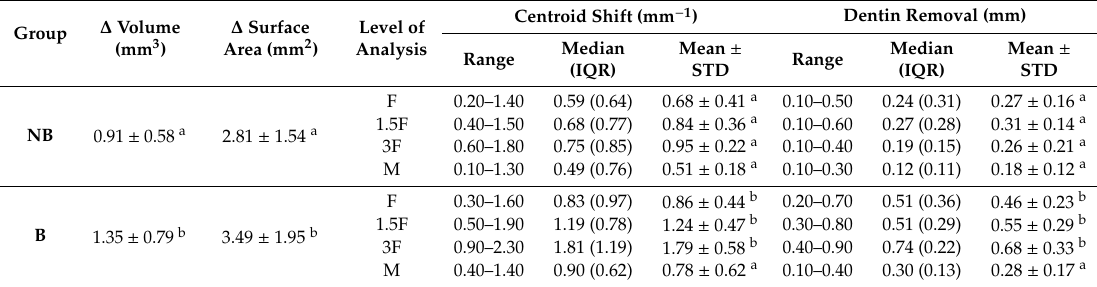
Table 2. Variations in 3D and 2D parameters in both groups after shaping (mean ± STD). Statistical significance indicated by p < 0.05. Superscript letters in the same column indicate significant di ff erences between groups ( p < 0.05). For 2D parameters, significance was compared for the same level of analysis. (1.5F = 1.5 mm from the furcation; 2D = two-dimensional; 3D = three-dimensional; 3F = 3 mm from the furcation; B = brushing group; F = furcation; M = point of maximum curvature; NB = no-brushing group; STD = standard deviation; IQR = interquartile range). Di ff erent superscript letters (a, b) in the same column indicate significant di ff erences between groups ( p <